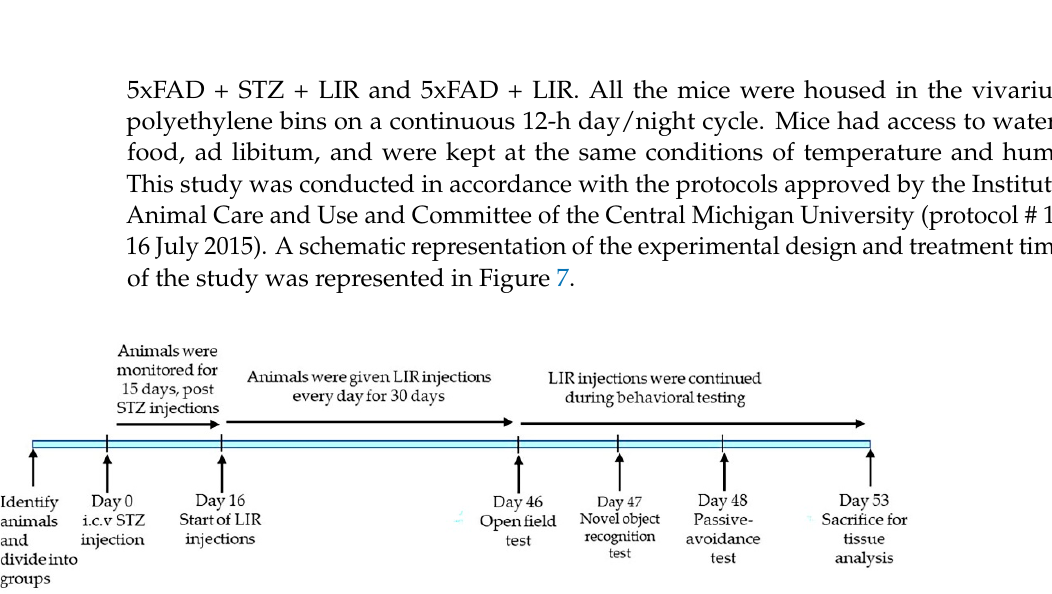
Figure 7. Schematic representation of the experimental design and treatment timeline of the study.